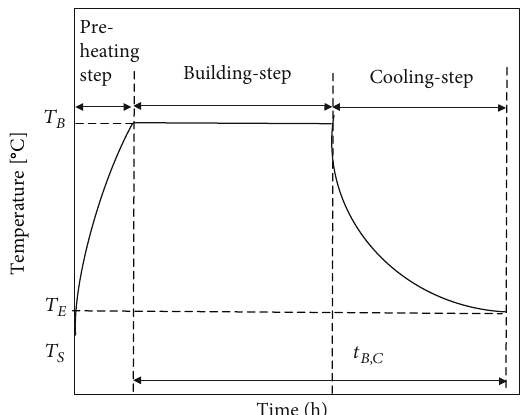
Figure 6: The heating pro fi le of polymeric material during SLS